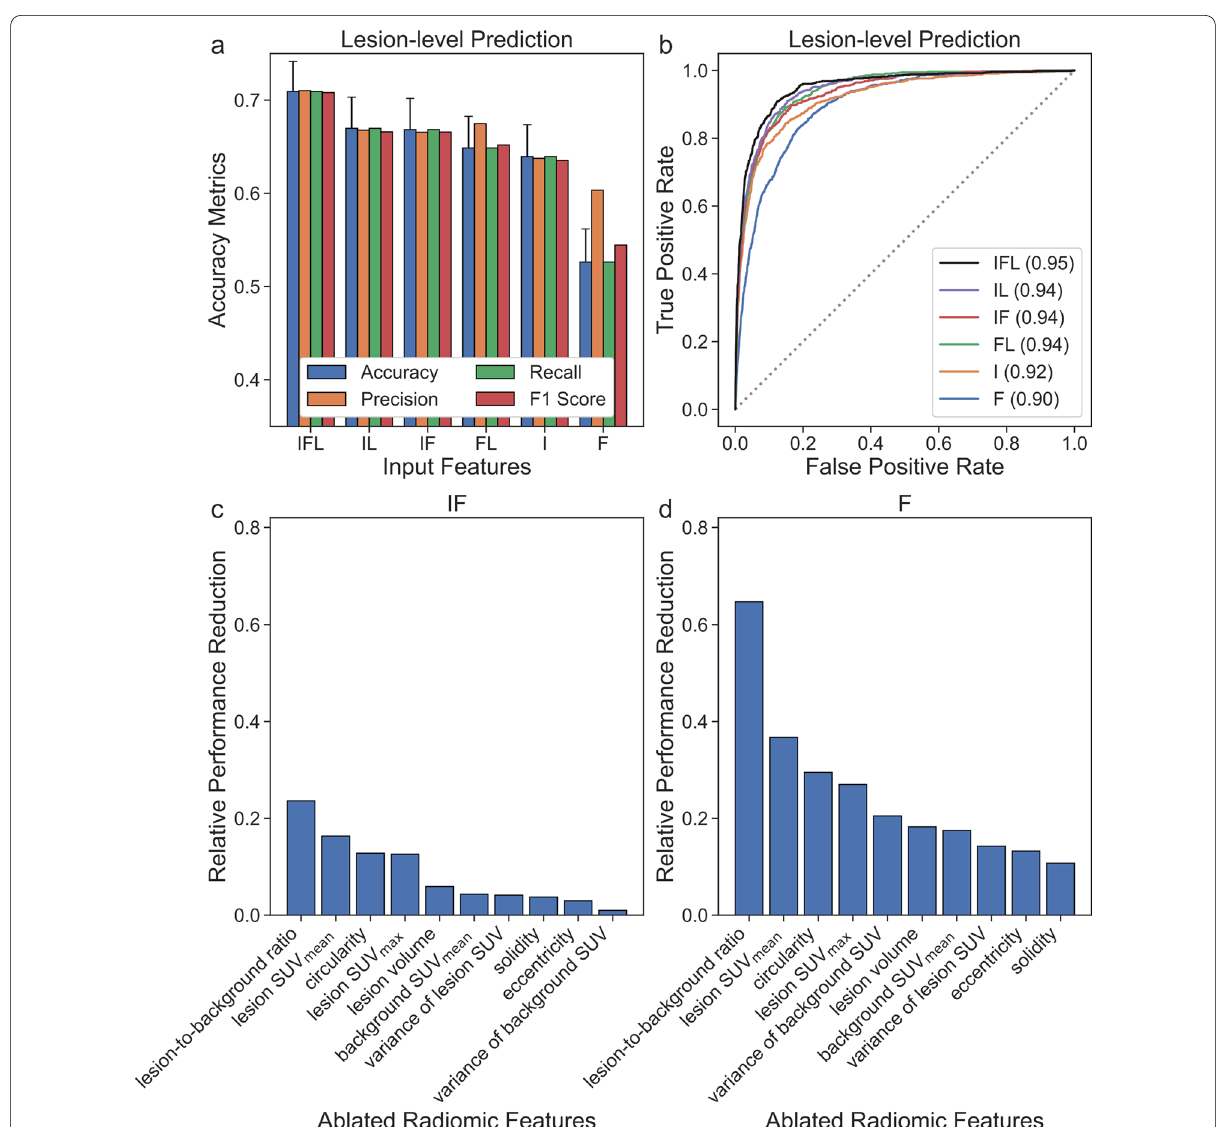
Fig. 7 Accuracy metrics ( a ) and ROC curves ( b ) for different input feature combinations and the relative reduction in overall accuracy due to radiomic feature ablation ( c , d ). Error bars correspond to 95% confidence intervals ( a